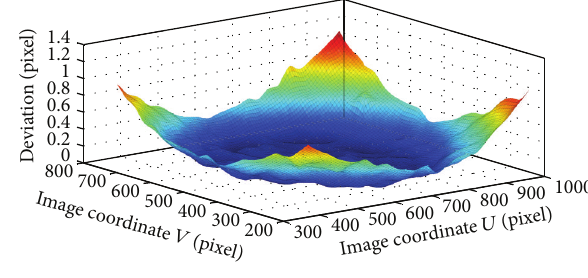
Figure 3: Deviation in 600 × 600